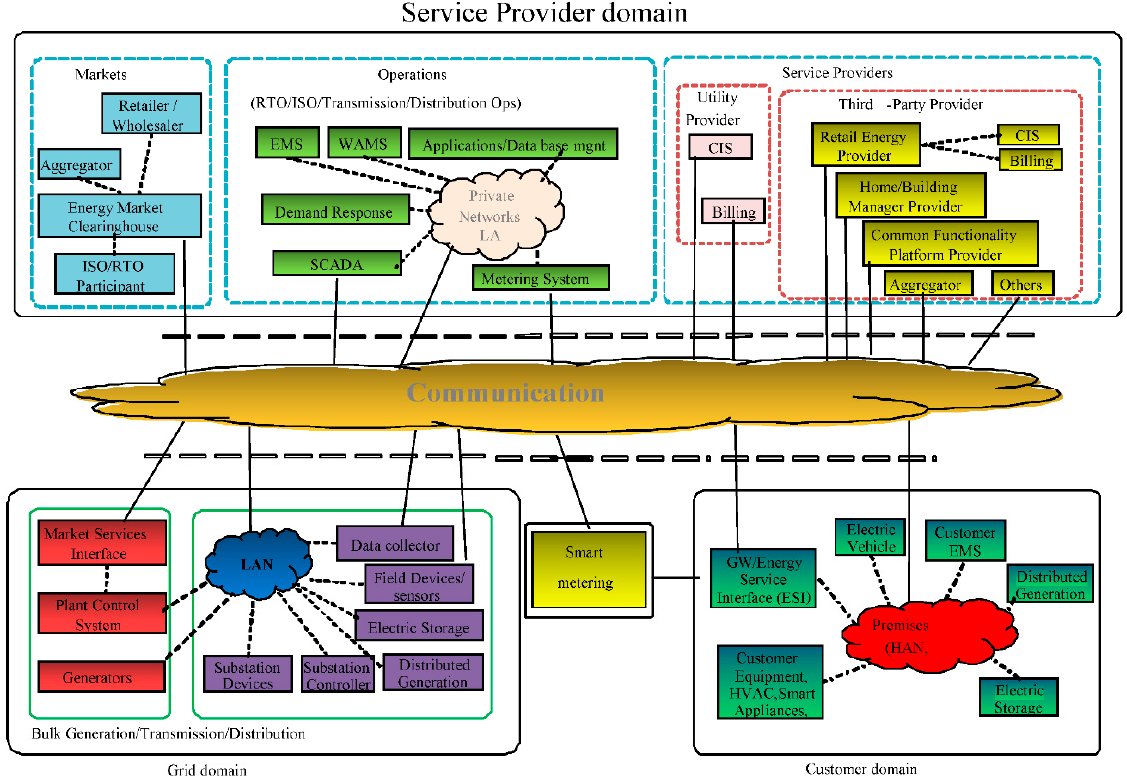
Figure 1. Suggested demand side management (DSM) of this